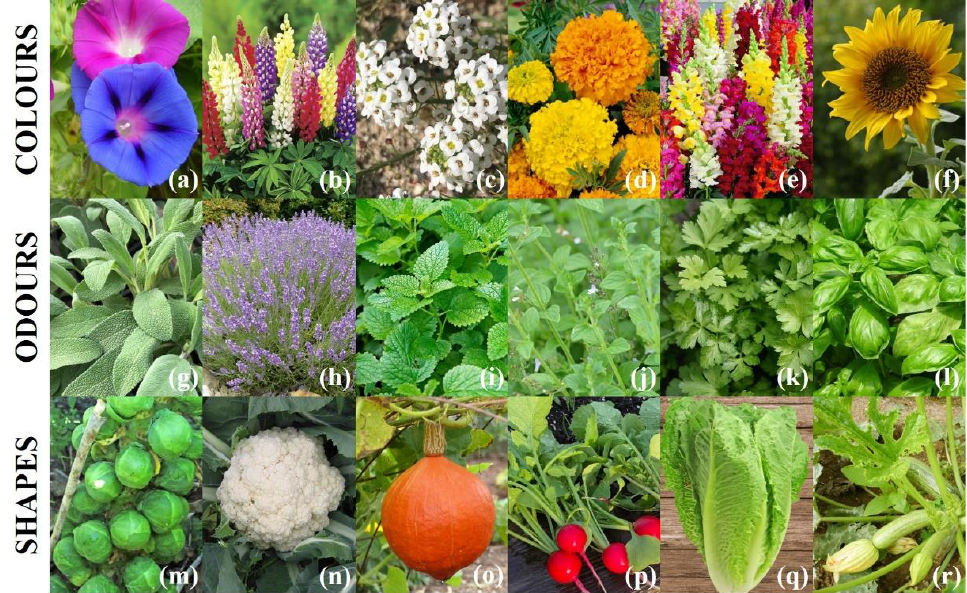
Figure 1. Plant species grown by patients in order to experience different sensory stimulations during the HTC. Color workstation: beach moonflower ( a ), lupin ( b ), madwort ( c ), marigold ( d ), snapdragon ( e ), sunflower ( f ). Odor workstation: common sage ( g ), lavender ( h ), lemon balm ( i ), lesser calamint ( j ), parsley ( k ), sweet basil ( l ). Shape workstation: Brussels sprouts ( m ), cauliflower ( n ), pumpkin ( o ), radish ( p ), romaine lettuce ( q ), zucchini ( r ).